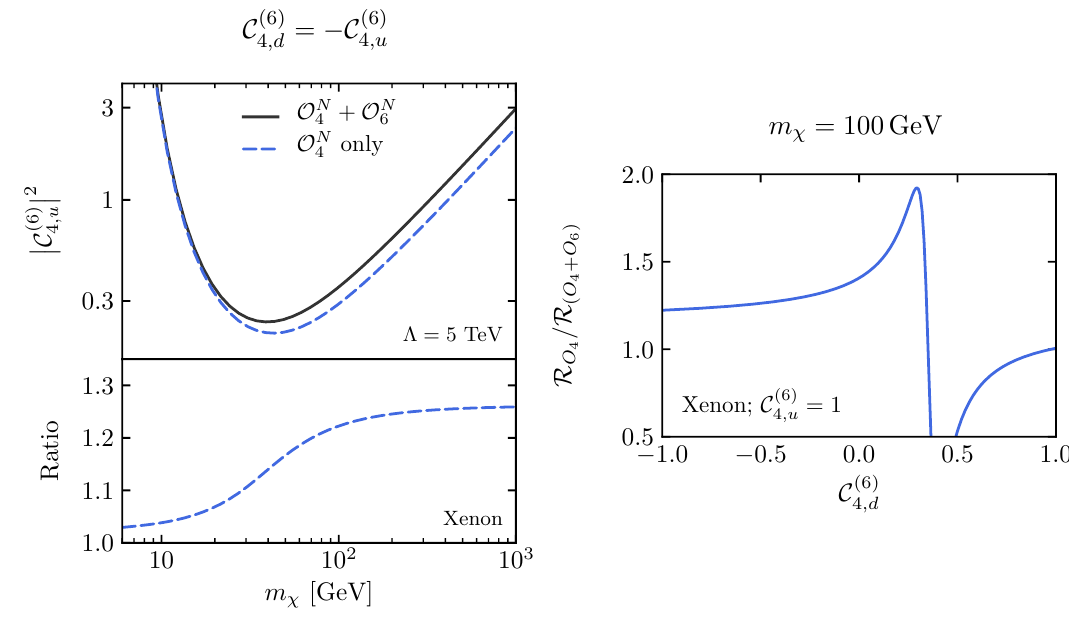
(6) (6) = 4 ;u 4 ;d C (cid:0)C N = 4 O N only (blue 4 O O 4 (6) for a (cid:12)xed 4 ;d C